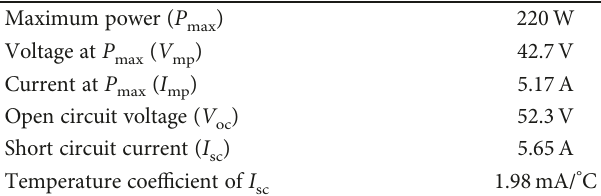
Figure 2: Equivalent circuit of PV cell simulation. Table 1: HIT-N220A01 PV module